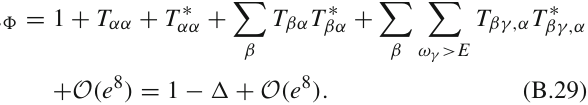
Fig. 2 A disconnected Feynman diagram contributing to I 1 for an ini- tial state of 3 electrons and 2 positrons. Additional contributions can be obtained by permuting the outgoing momenta among the external lines associated with the outgoing particles. Diagrams in which the first and third electron, and also the second and third electron must be also